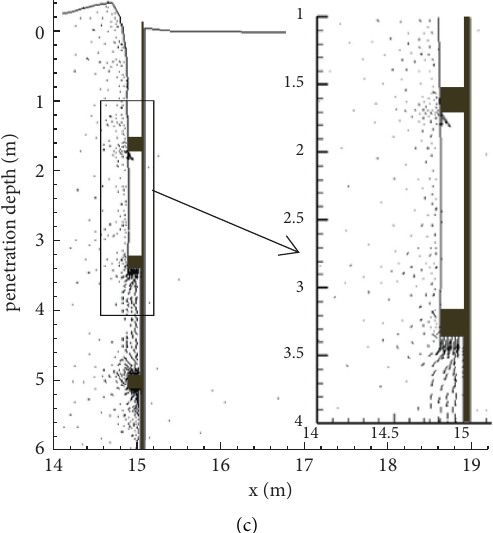
Figure 9: Effect of soil strength on soil movement. (a) S